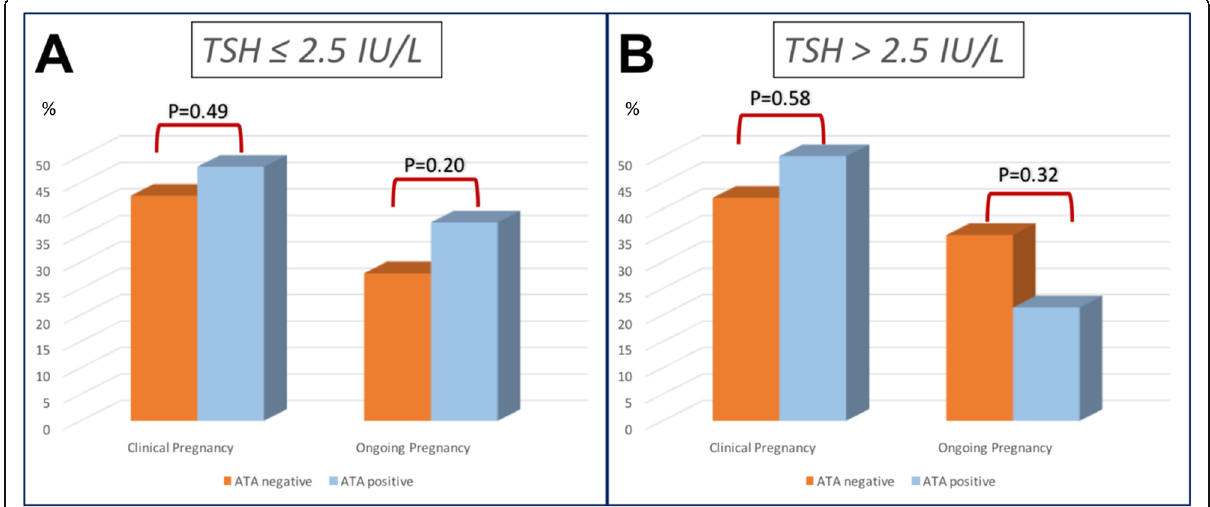
Fig. 2 The pregnancy outcomes of patients according to the TSH levels ( a TSH ≤ 2.5 IU/L, b TSH > 2.4